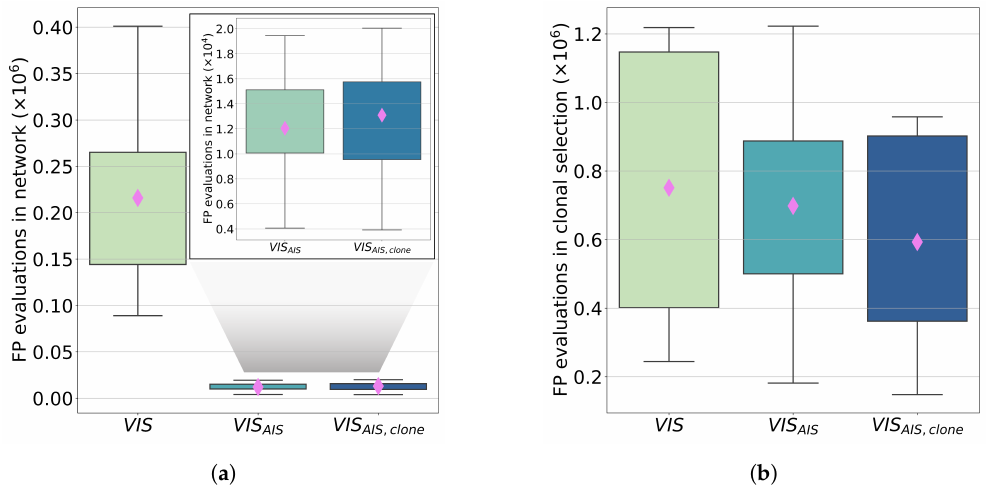
Figure 7. Box plots of the FP executions in the 30 runs of the three tested approaches. The pink diamonds represent the mean value of each case: ( a ) describes the FP evaluations for the randomly generated cells. A zoom of the results for the two classifier approach is reported in the upper right corner; ( b ) describes the FP evaluations for the locally mutated cells